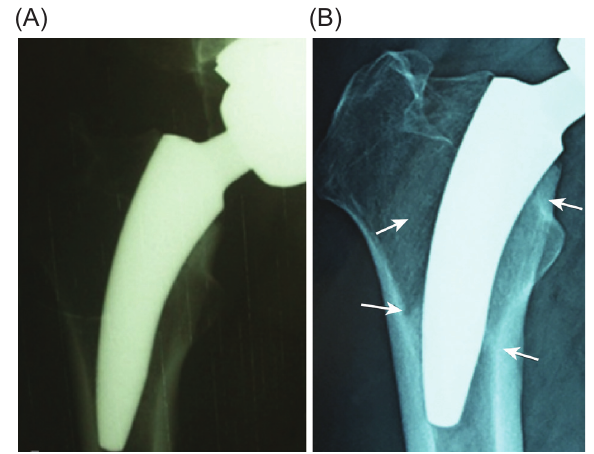
Figure 4. Anteroposterior radiographs of 40-year-old male: (A) immediate post-operative and (B) two years follow-up. The stem is considered in neutral alignment. Two years later; osseointegration evidenced by increased trabecular density bridging from lateral and medial cortex to the stem (spot welds – lower arrows) as well as rounding of the lower neck (upper